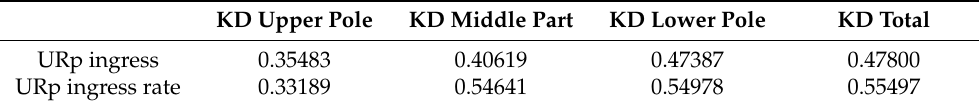
Table 3. Comparison of recipient, donor, and periprocedural characteristics between recipients with the occurrence of postoperative ureterovesical anastomosis complications and those without after kidney transplantation (n = 196). Quantitative variables are expressed as median, minimum, and maximum. For qualitative factors, absolute and relative frequencies are